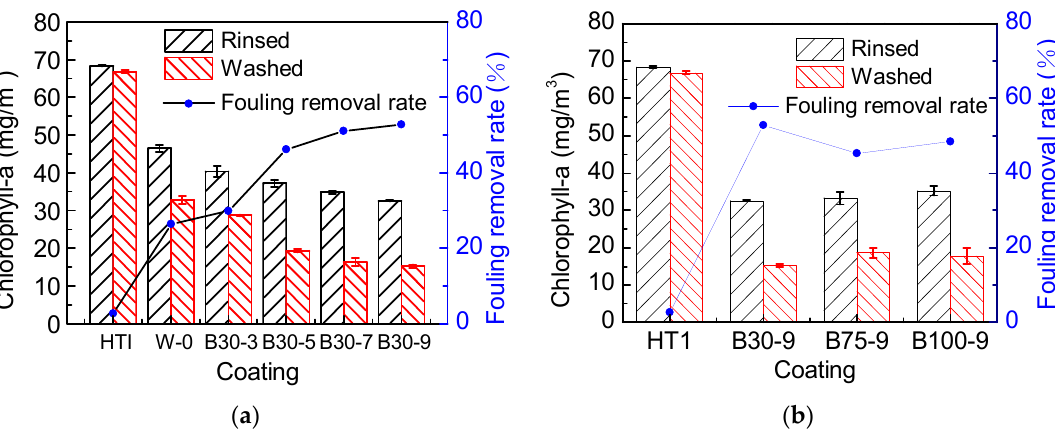
Figure 7. The influence of the addition amount ( a ) and viscosity ( b ) of PSO on the adhesion of Navicula Tenera